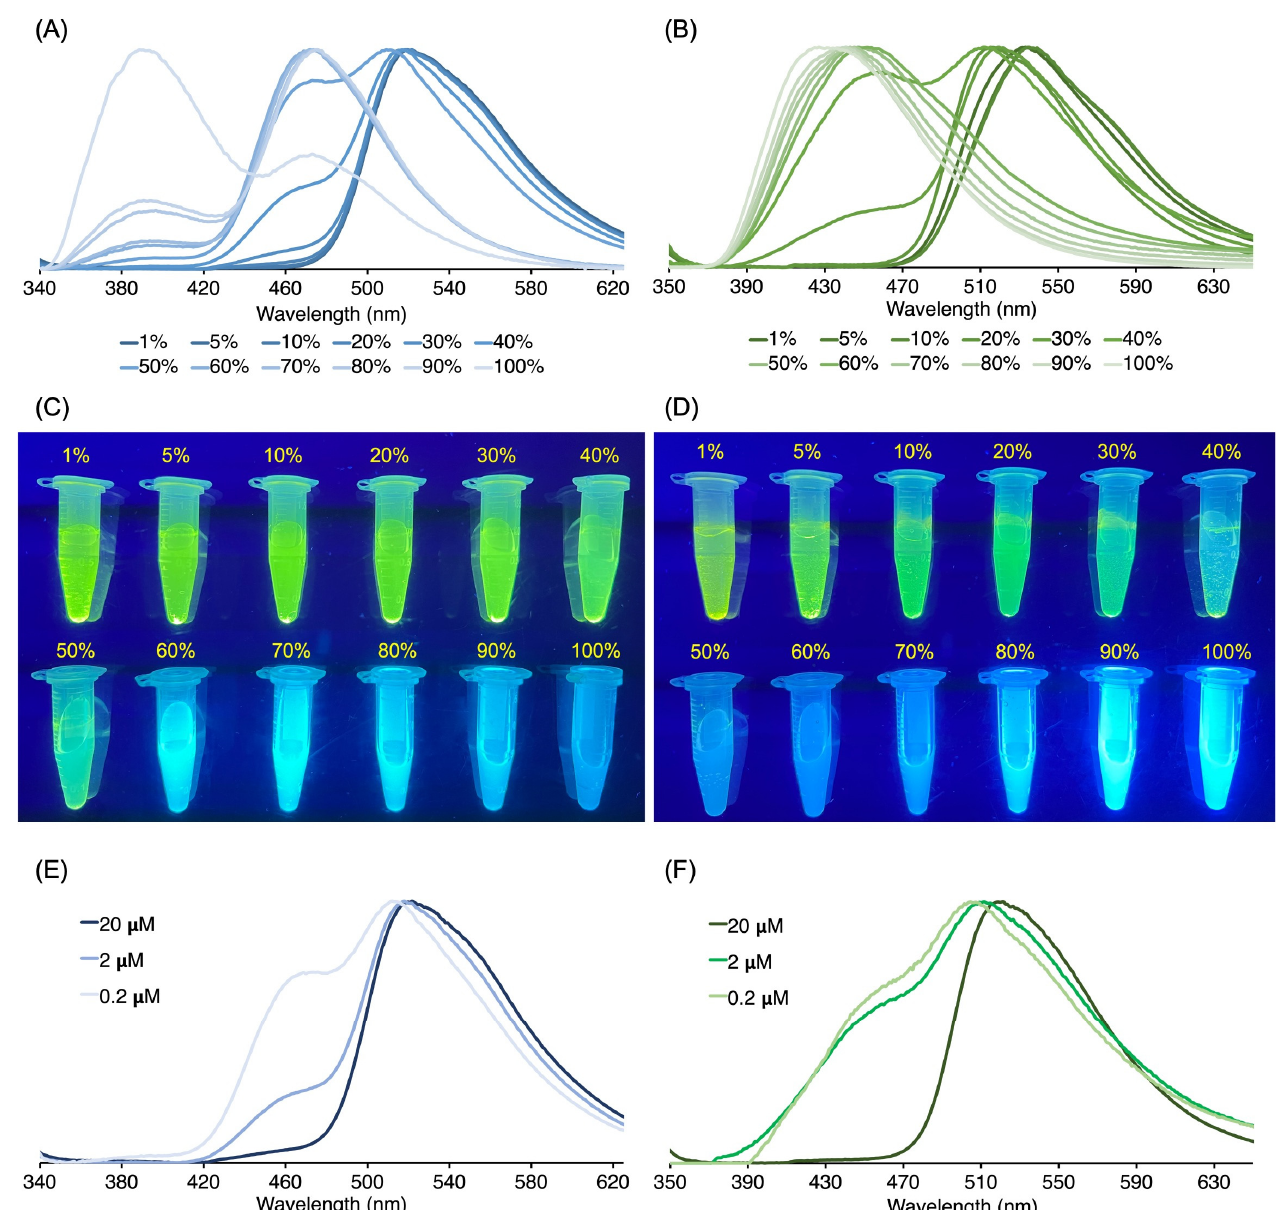
Figure A1. ( A ) Emission spectra (normalized) of 14 (20 μ M ) in various ratios of DMSO/H 2 O at room temperature ( λ exc = 318 nm). ( B ) Emission spectra (normalized) of 15 (20 μ M) in various ratios of DMSO/H 2 O at room temperature ( λ exc = 330 nm). ( C ) Visualization (UV illumination) of 14 (20 μ M ) in various ratios of DMSO/H 2 O at room temperature. ( D ) Visualization (UV illumination) of 15 (20 μ M ) in various ratios of DMSO/H 2 O at room temperature. ( E ) Emission spectra (normalized) of 14 (with various concentrations) in H 2 O containing 20% DMSO at room temperature ( λ exc = 318 nm). ( F ) Emission spectra (normalized) of 15 (with various concentrations) in H 2 O containing 20% DMSO at room temperature ( λ exc = 330 nm).